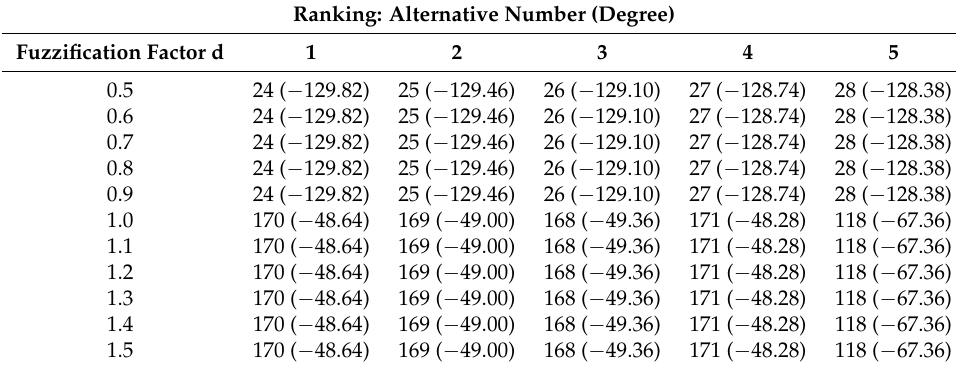
Table 6. Sensitivity analysis result with MF 2